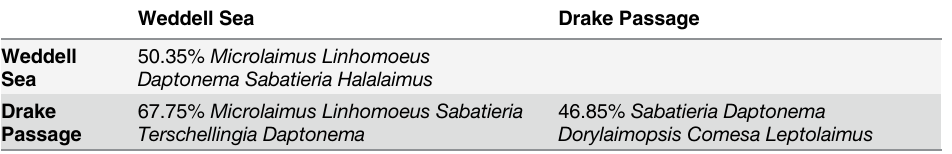
Table 5. Dissimilarity (%) of nematode assemblages within and between areas (averaged over repli- cates and sediment depths) and first five genera contributing most to observed differences